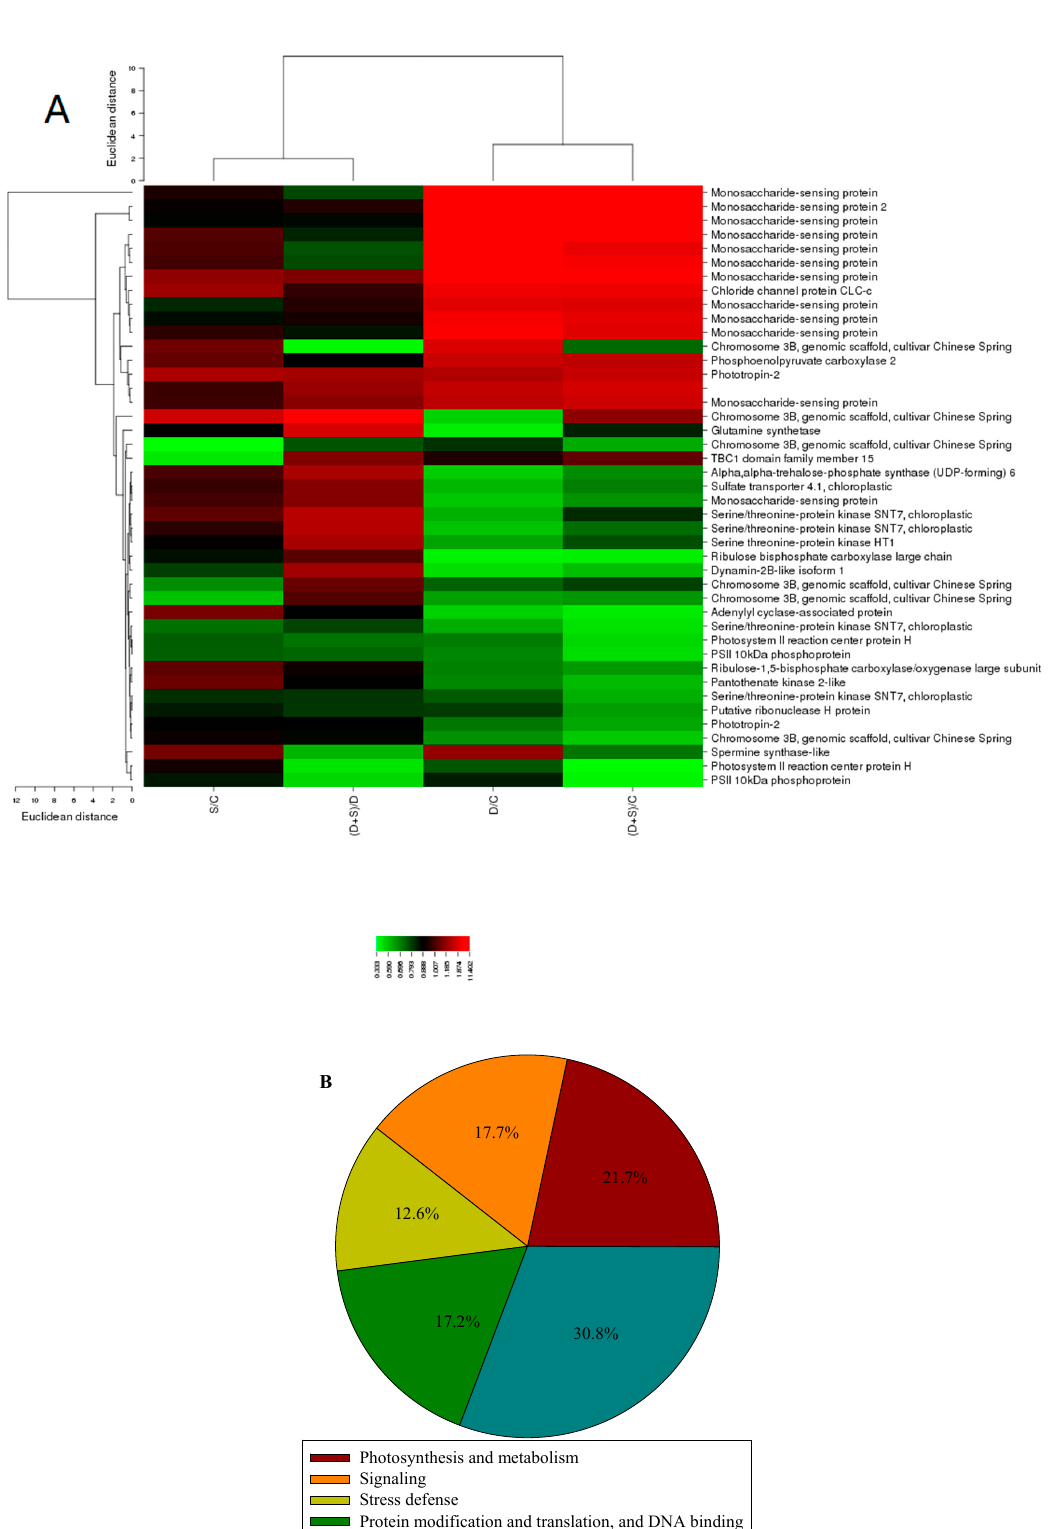
Figure 4. ( A ) Cluster analysis and ( B ) functional classification of significant differentially phosphorylated peptides in leaves of winter wheat among four different treatments. The color scale bar at the left of the hierarchical cluster analysis indicates the increased (red) and the decreased (green) peptides. For a detailed description of treatment conditions, please refer to the legend of Figure 1.